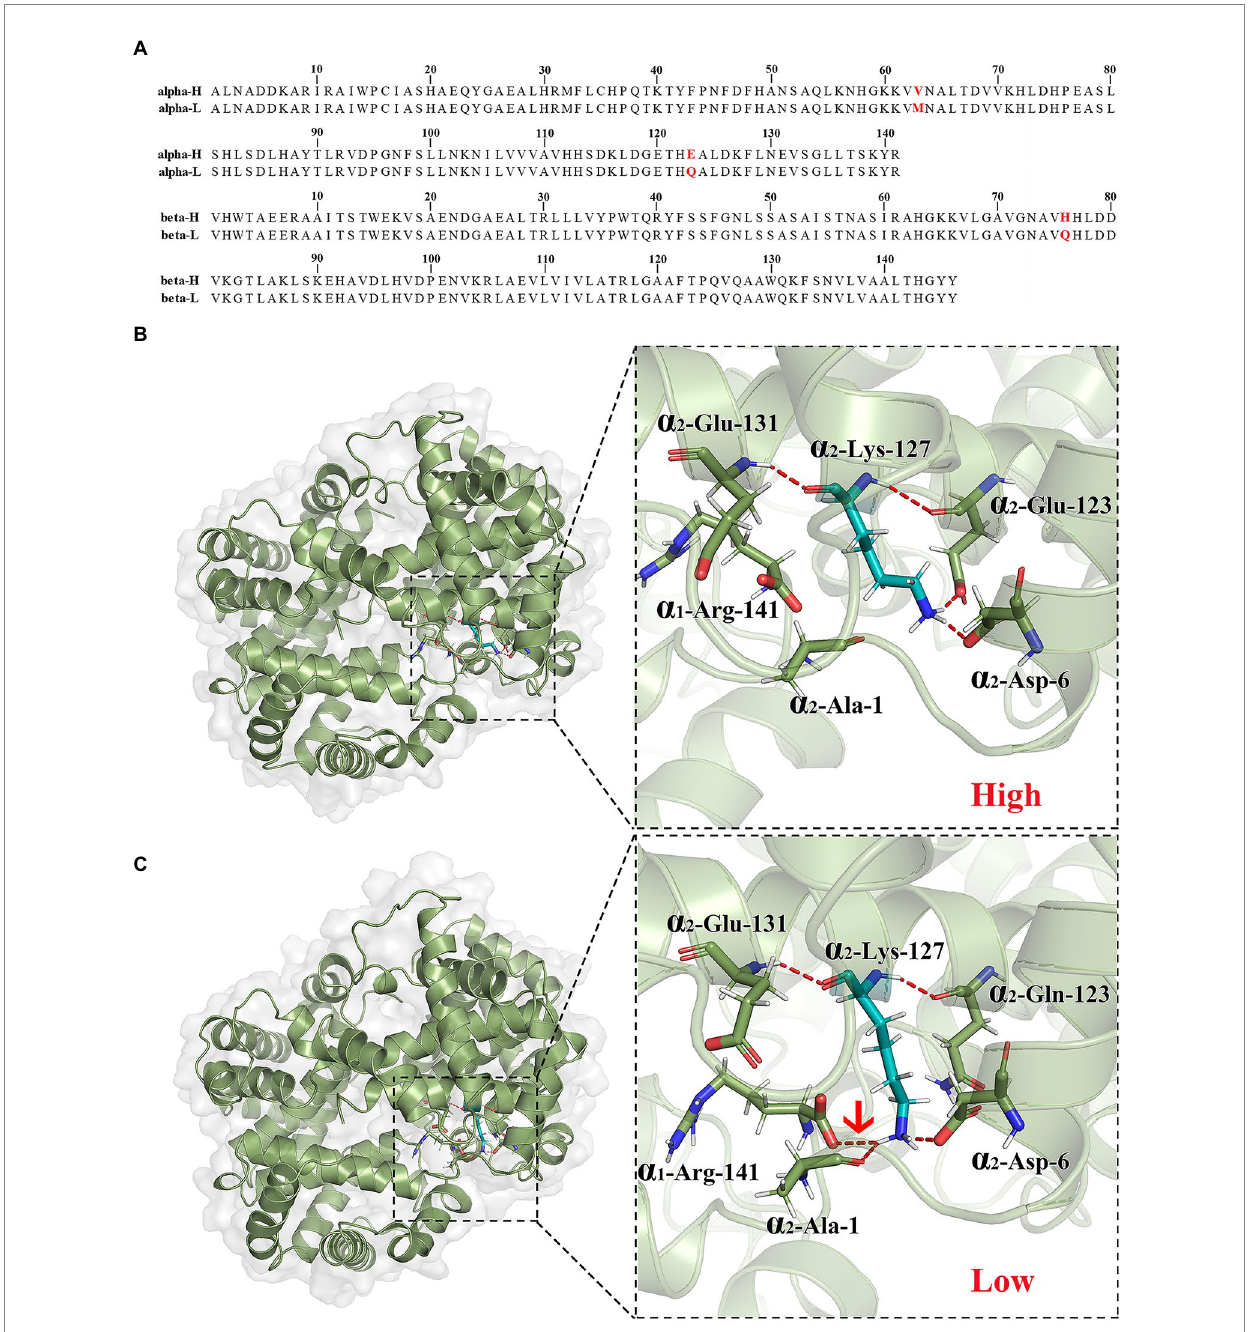
FIGURE 2 Amino acid substitution of Gln123Glu on α 2 chain affects the spatial structure of Hb of black-spotted frog. Amino acid sequence alignments of α - and β -chains in hemoglobin of high- and low-altitude black spotted frog (A) . The constructed spatial structure of Hb in high-altitude black-spotted frog (B) . The constructed spatial structure of Hb in low-altitude black-spotted frog (C) . Substitution of Gln to Glu at position 123 on α 2 chain of high-altitude frog could form an additional hydrogen bond with 127Lys on the same chain, resulting in the change of Hb conformation and the loss of hydrogen bond interaction between α 1 and α 2 chain compared with the low-altitude frog. Red dashed lines indicated the hydrogen bonds formed between 127Lys on α 2 chain and 141Arg on α 1 chain in the Hb of low-altitude frog. Each experiment has been carried out three